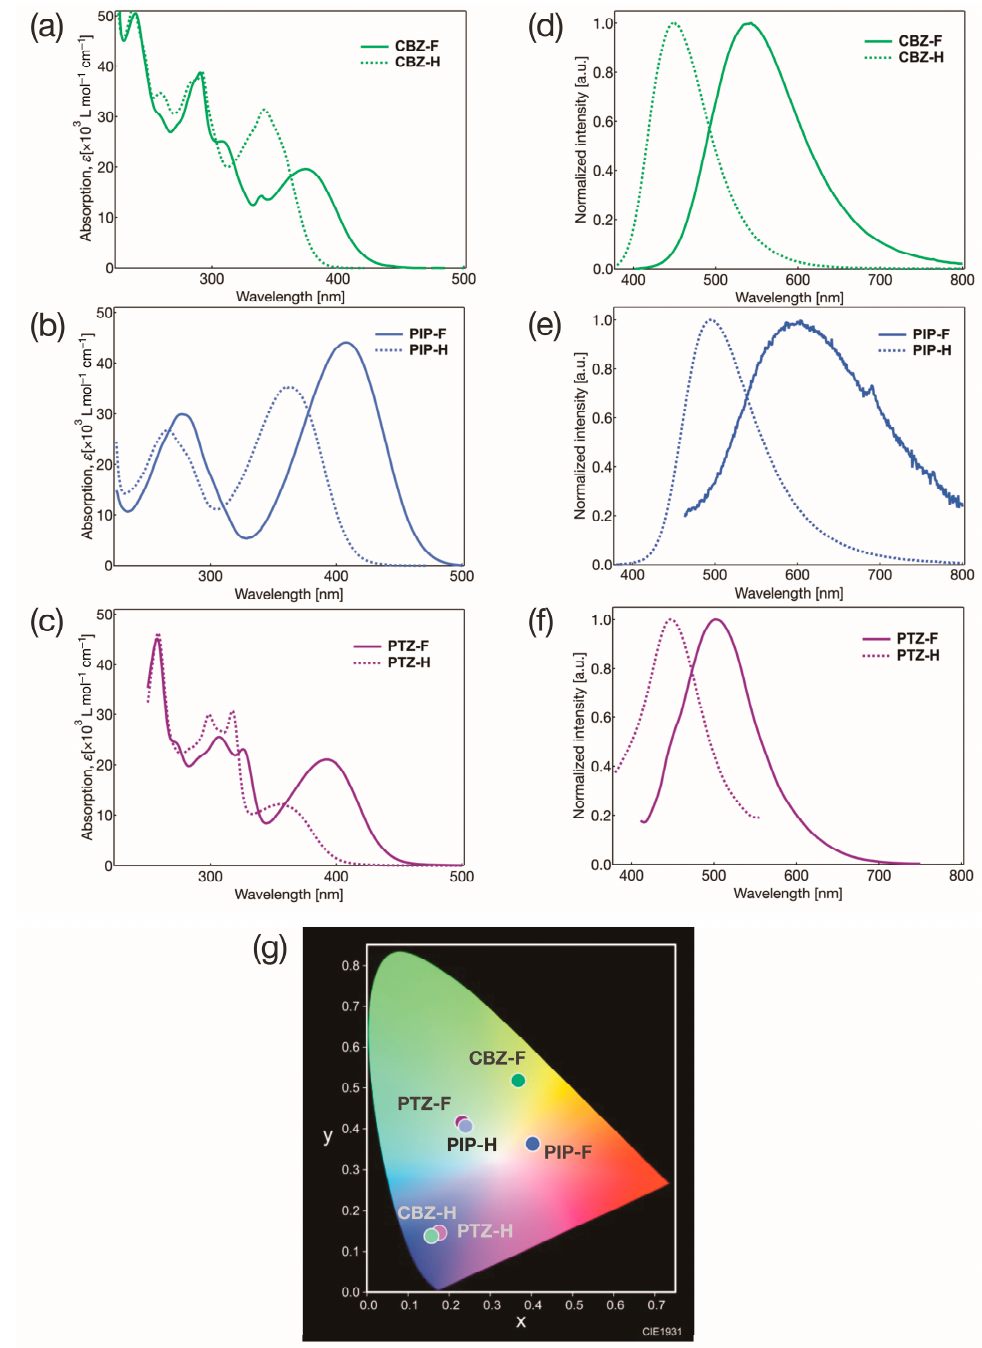
Figure 3 Figure 3. UV–vis absorption spectra of ( a ) CBZ-F and CBZ-H , ( b ) PIP-F and PIP-H , and ( c ) PTZ-F and PTZ-H in CH 2 Cl 2 . PL spectra of ( d ) CBZ-F and CBZ-H , ( e ) PIP-F and PIP-H , and ( f ) PTZ-F